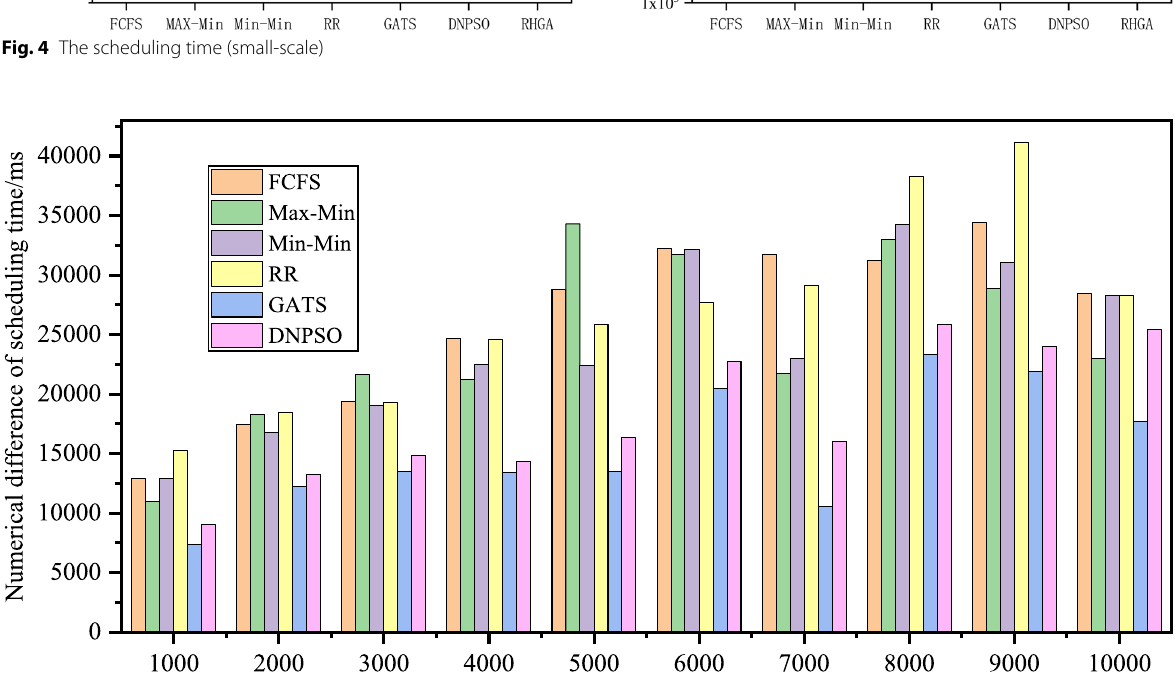
Fig. 4 The scheduling time (small-scale)